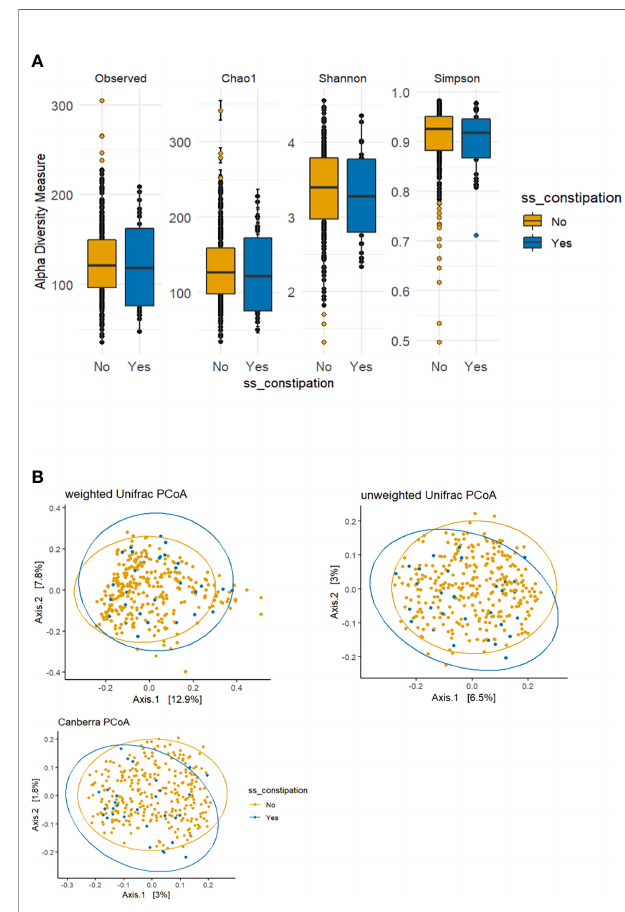
FIGURE 2 | Alpha and beta diversity plots to visualize the difference in microbiota structure between the constipated group versus the non-constipated group. (A) The boxplot fi gures show the alpha diversity of the bacterial communities by means of observed amplicon sequence variants (ASVs) and Chao1, Shannon, and Simpson indices. Median and lower and upper quartiles are shown on the plots. ss_constipation, status of constipation. (B) The principal component analysis (PCoA) plots with the following three distance measures: Canberra, unweighted unique fraction metric (UniFrac), and weighted UniFrac.